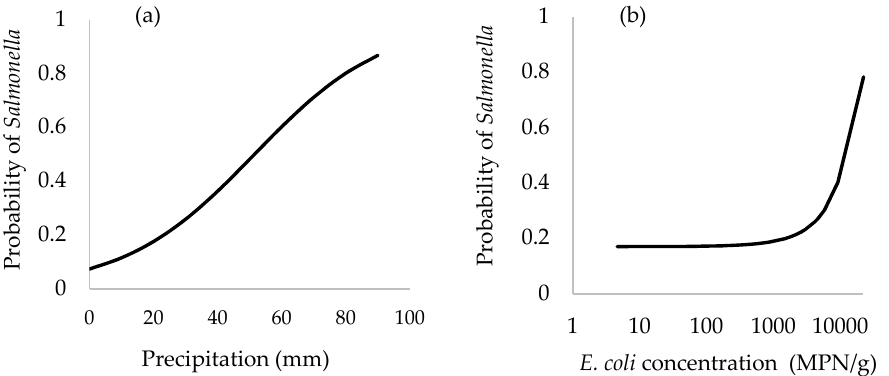
Figure 6. Predicted probability of detecting Salmonella in pooled oyster samples as a function of: ( a ) average precipitation during previous 7 days; ( b ) the levels of EC (MPN/g oyster meat).